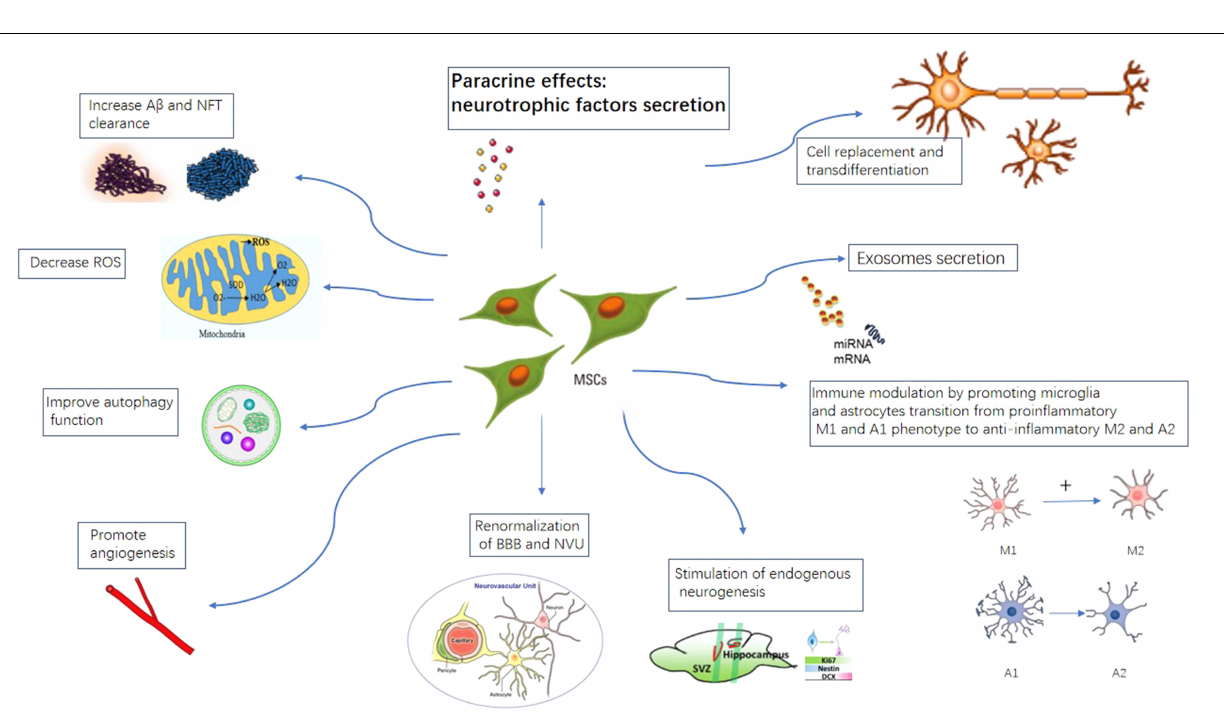
Frontiers in Cellular Neuroscience |